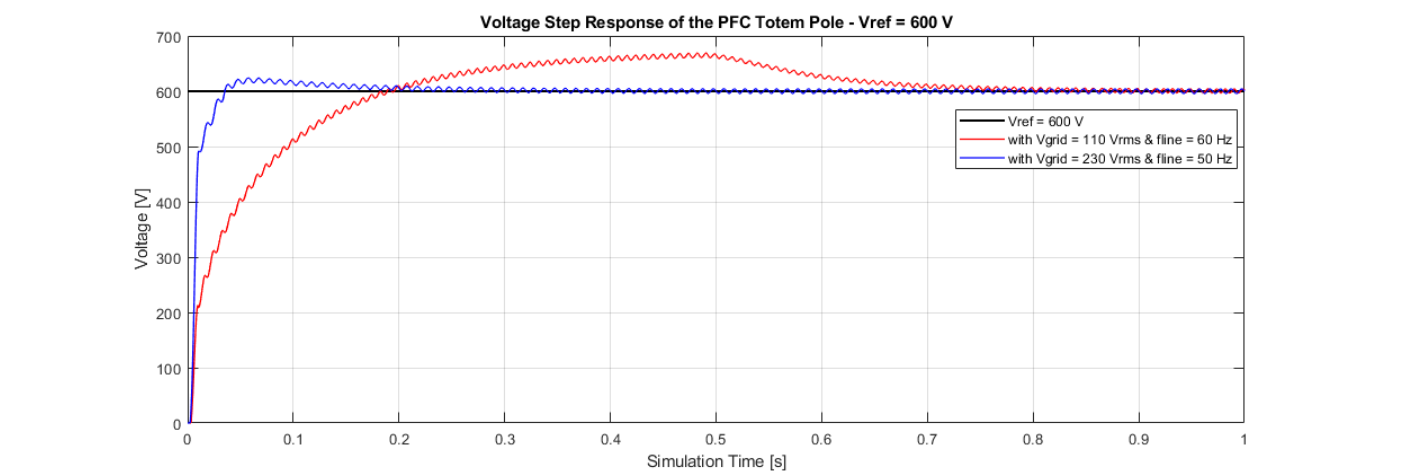
Figure 15. Voltage control of the Totem Pole with V ref = 600 V.